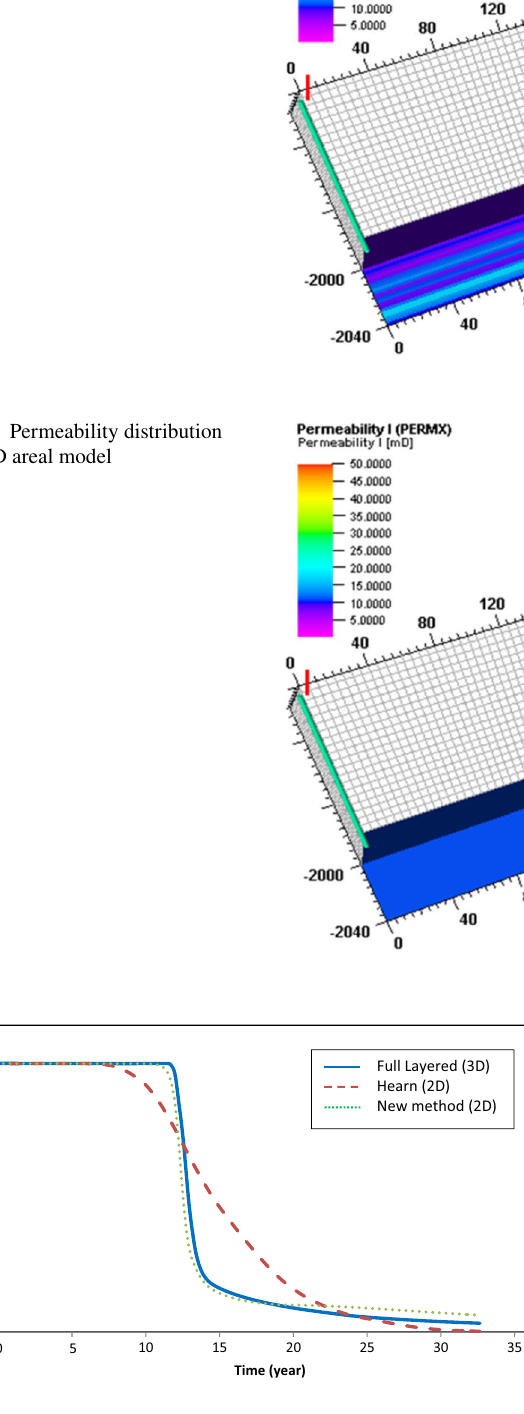
Fig. 6 Oil production rate comparison for constant flow rate case Fig. 7 Oil recovery comparison for constant flow rate